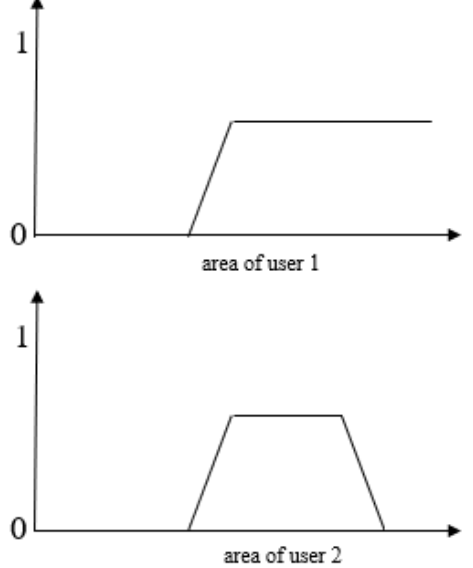
Figure 6. Areas of the users of the failure ‘P 4 ′ in the smartphone cases .